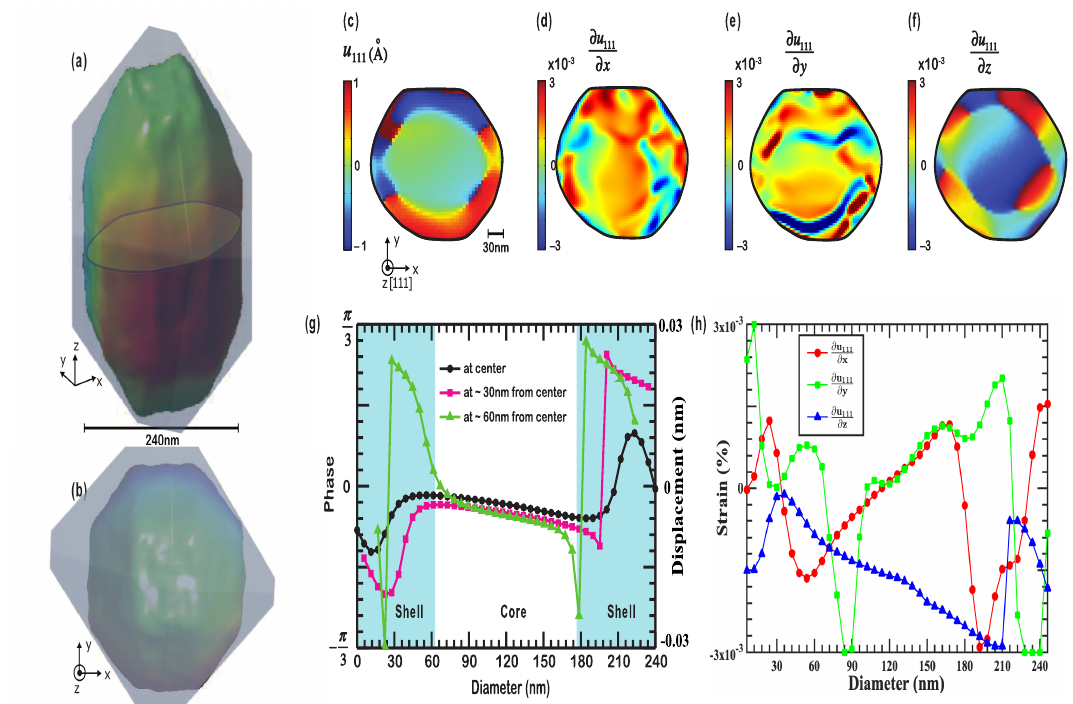
Figure 2. Reconstructed projections of the displacement and strain. ( a , b ) 3D isosurface projections of the displacement field u 111 and shape morphology of the nanoparticle. ( c – f ) 2D projections that are extracted from the central slices of the reconstructions, showing strain inhomogeneity of the core and heterogeneity within the shell of the nanoparticle. The strain in ( c – f ) with non-uniform structure without symmetry within the core; while the strain within the shell is diverse when comparing the components in the three orthogonal directions as shown in ( d – h ). Line plots showing smooth variation and inhomogeneous strain within the core layer of the nanoparticle (Ni) and large phase jumps in the NiO shell region depicting the presence of singularities such as defects and dislocations. In ( g ), the phase is plotted from the central slices of the 3D reconstructed particle, 30 nm and 60 nm away from the central slices of the 3D particle, respectively. In ( h ), the plot was extracted from the one end of the particle to the other end of the particle, that is, from the shell–core–shell for the entire particle for the central slice